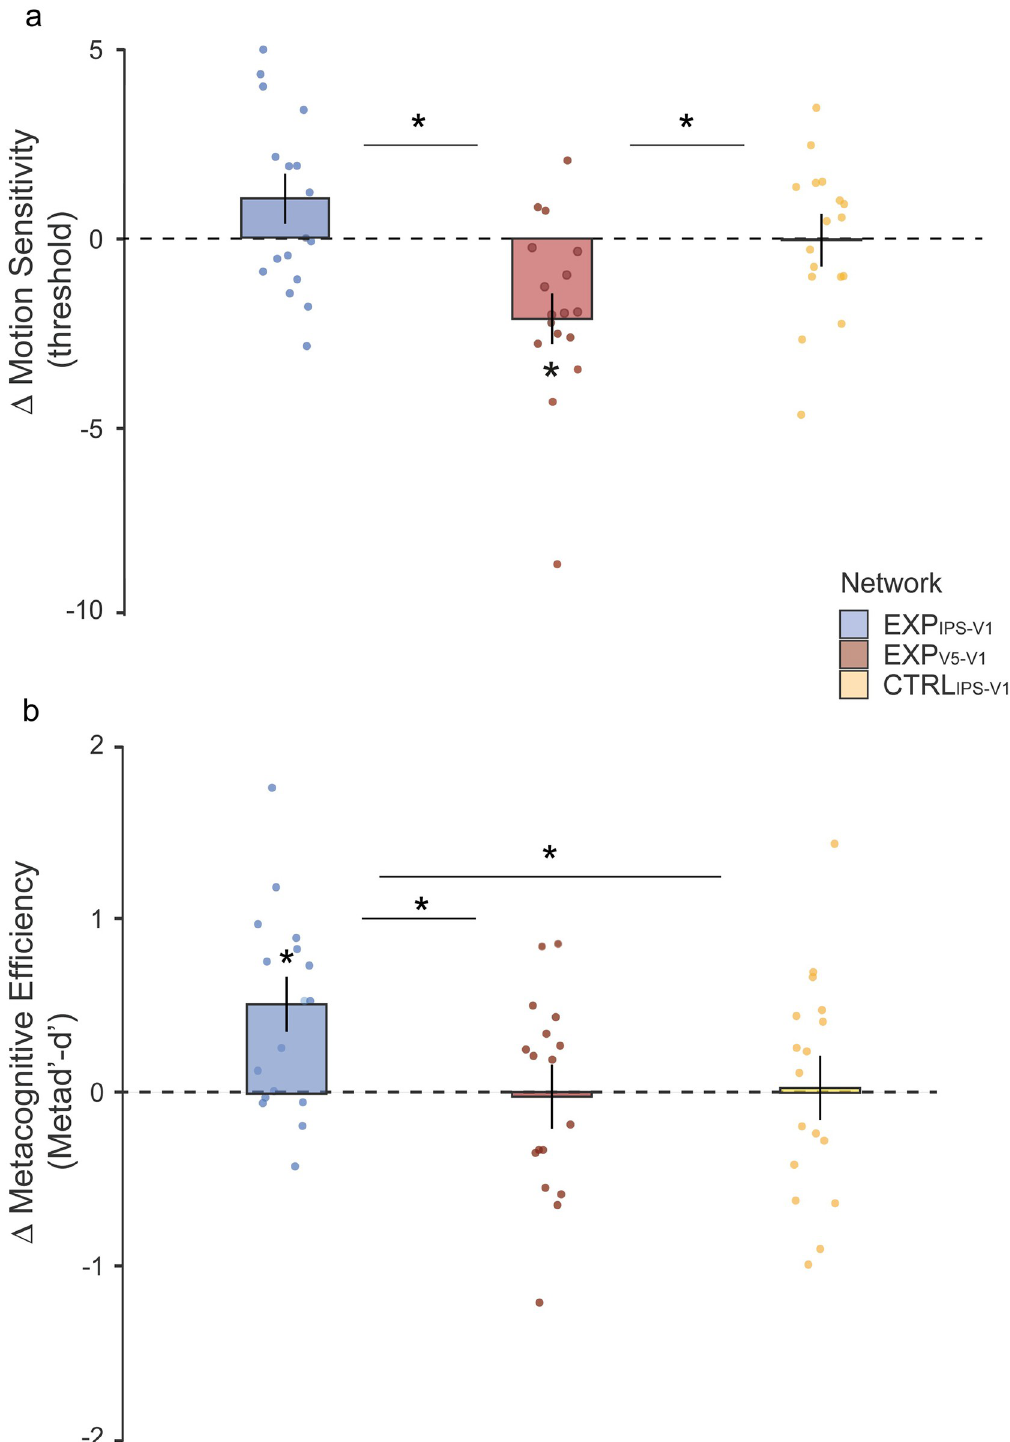
Fig 3. ccPAS effect on decision-making. (a) Motion threshold following stimulation. Filled bars represent the mean change Δ in sensitivity threshold (e.g., differences between Post ccPAS and BSL), and error bars represent the SEM. Individual data points are plotted by scattered dots. Asterisks point out significance ( � p < .05) for Exp V5-V1 mean and between group means. ( b) Metacognitive efficiency following stimulation. Filled bars represent the mean change Δ in metacognition with error bars representing SEM. Individual performances are plotted by scattered data points. Asterisks point out significance ( � p < .05)